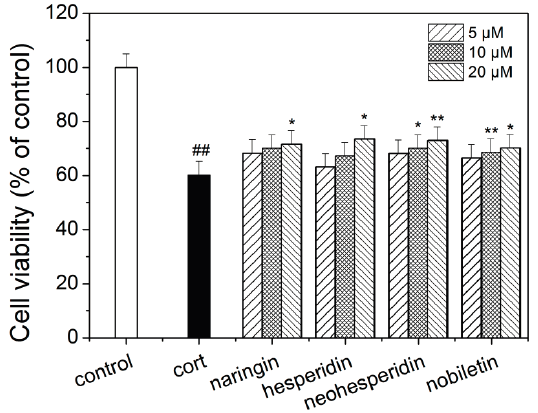
Figure 6. Effect of major components on the cell viability in corticosterone-treated PC12 cells. The results are expressed as mean ± SD ( n = 3). ## p < 0.01 as compared with control group; * p < 0.05 and ** p < 0.01 as compared with the corticosterone group. Cort: